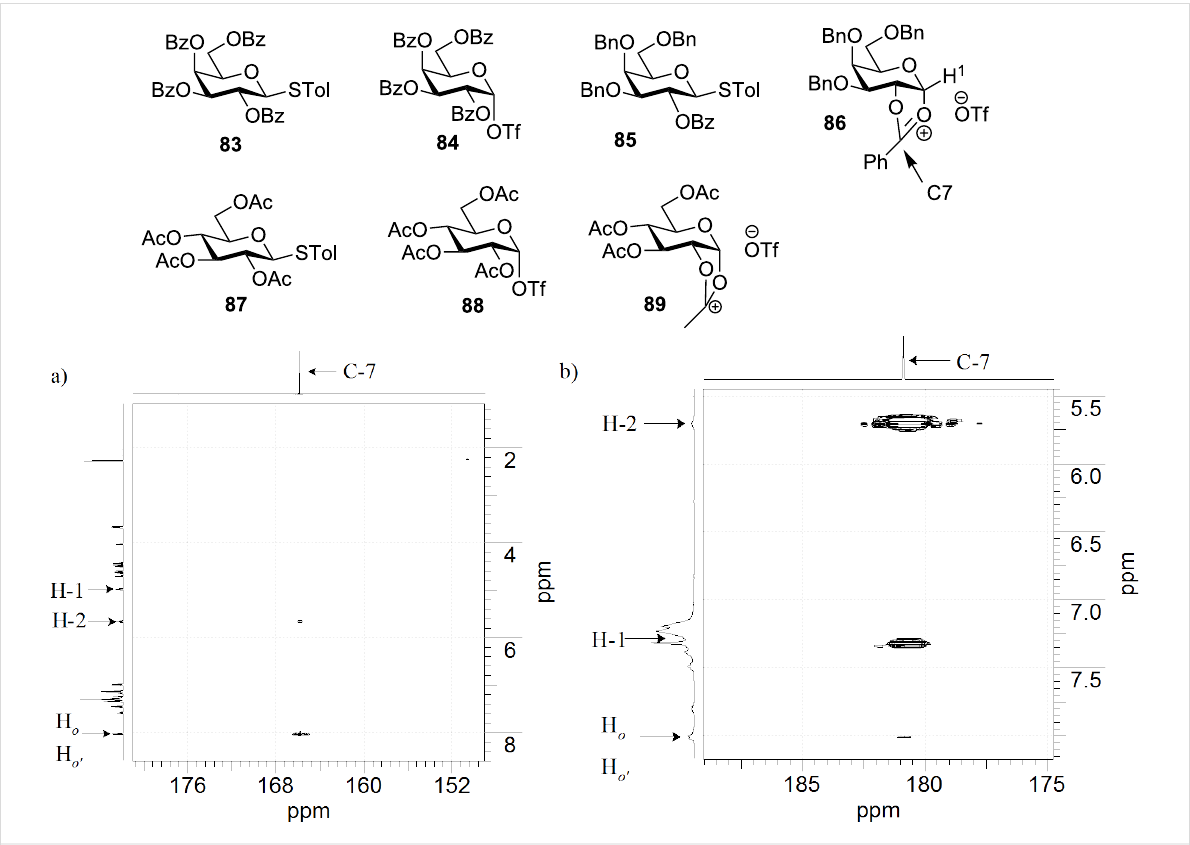
Figure 3: The preactivations of glycosyl donors 83 , 85 and 87 were investigated by low temperature NMR, which gave 84 , 86 , 88 / 89 as dominant intermediates, respectively. gHMBC (CDCl 3 , 600 MHz) of donor 85 a) before and b) after preactivation at − 60 °C. The correlation peak emerged after activation between C-7 and H-1 supports the structure of the dioxalenium ion 86 formed from preactivation.